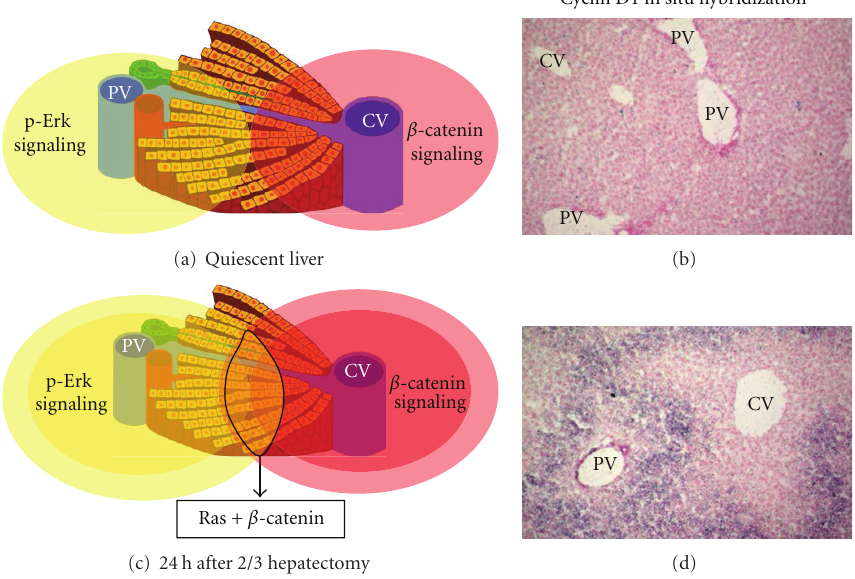
Figure 2: Hypothesis for a crosstalk between β -catenin and Ras signalling pathways to control hepatocyte proliferation. (a) In the quiescent liver, phospho-erk signaling is described as being periportal, while β -catenin is pericentral; (b) no cyclin D1 mRNA is detected in these conditions; (c) 24 h after 2/3 hepatectomy, there is an extension in the β -catenin and the ras activation territories. We now hypothesize that it could generate a common territory in which both which phospho-erk and β -catenin signalings are activated; (d) this can be exemplified by cyclin D1, which is a target of β -catenin, potentiated by ras signaling. Its localization after hepatectomy is restricted to the midlobular region. PV = portal vein; CV = central